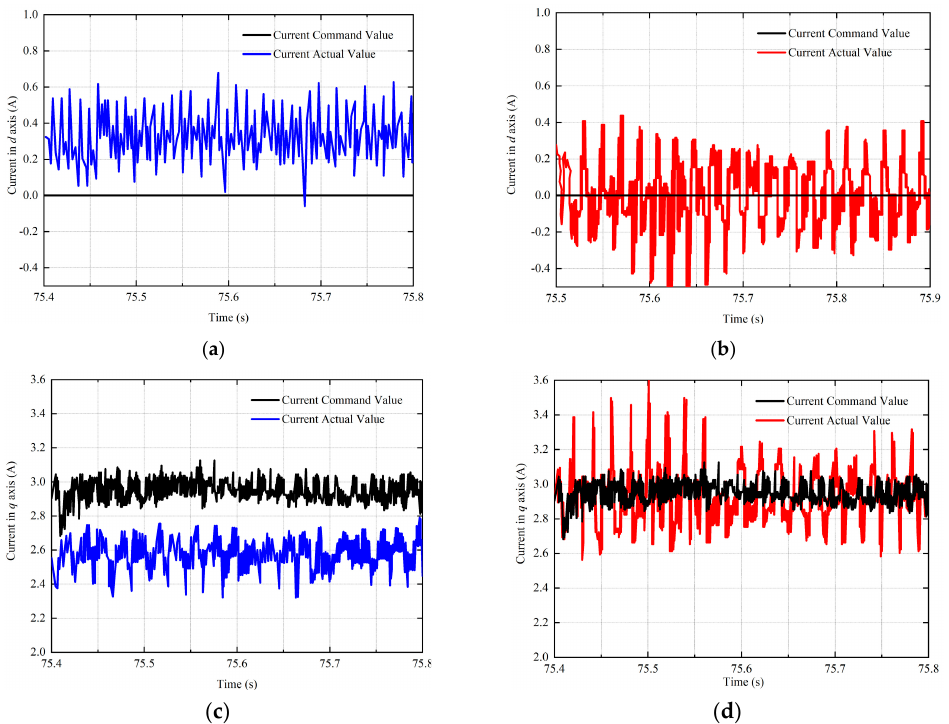
Figure 13. Current response comparison based on flux linkage changed in controller ' 1.5